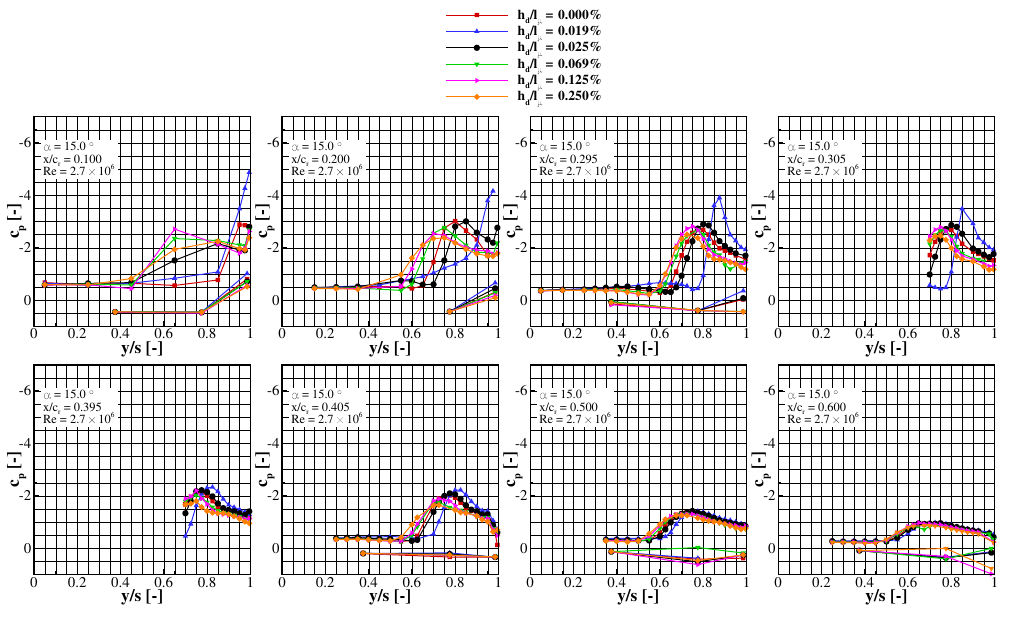
Figure 11. Leading-edge roughness effect on the spanwise mean surface pressure distribution, at 10 6 and α = 15 ◦ . Re = 2.7 ×